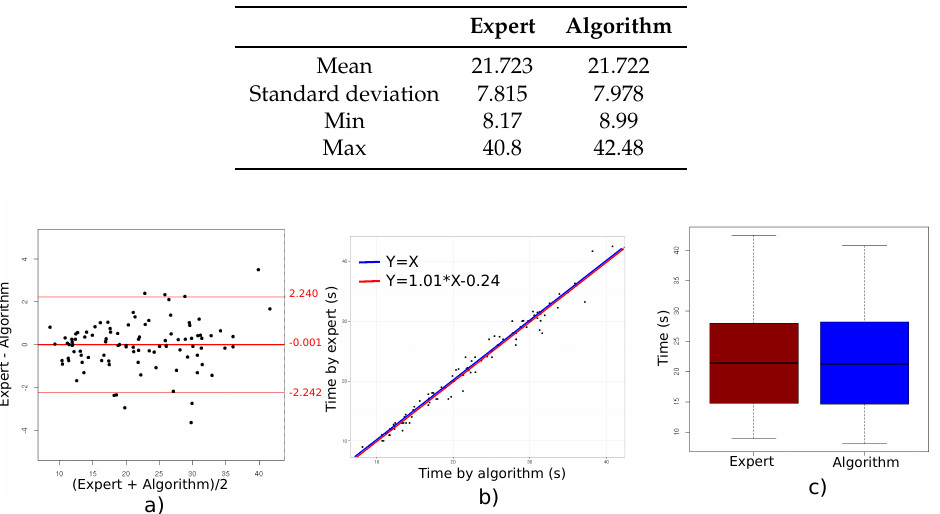
Figure 4. Different representations of the duration parameter. ( a ): Bland and Altman plots with three values by participants corresponding to the test duration according to the clinicians and to our algorithm; ( b ): scatter plots of all the data with red lines indicating the identity line and blue line corresponding to the linear best-fit; ( c ): boxplot showing the median and variability of the recorded data. The level of agreement between the algorithm and clinicians measurements was